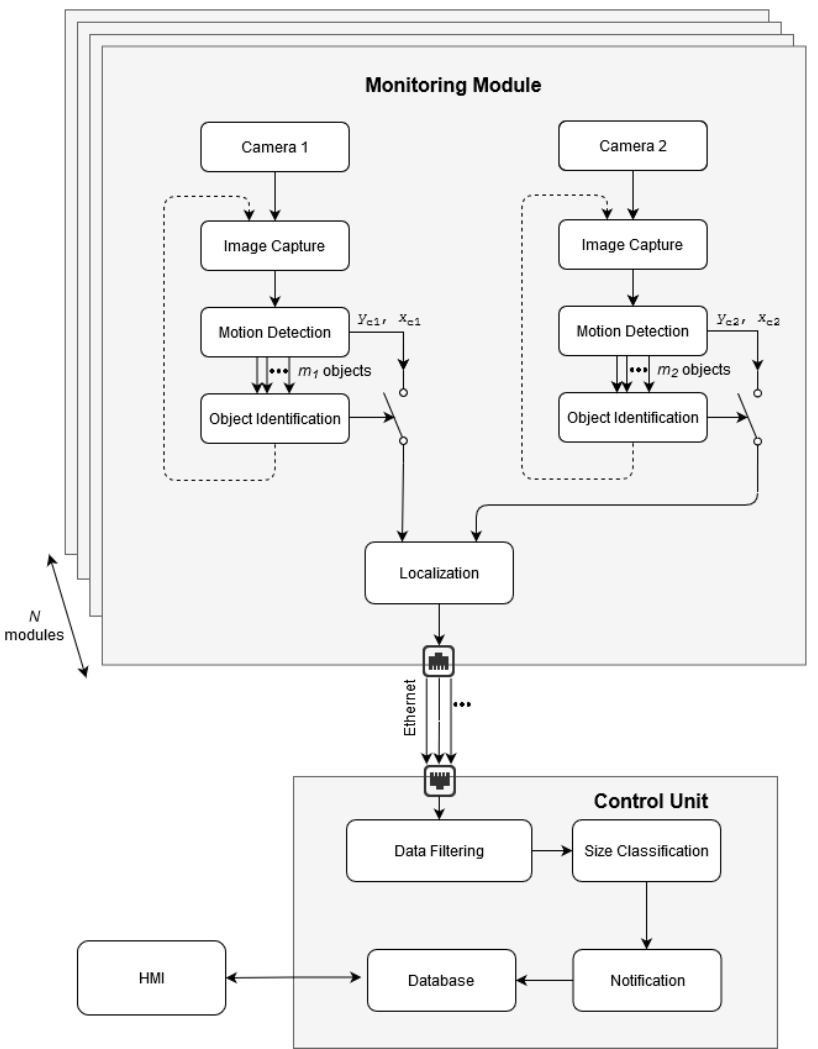
Figure 7. General system processing architecture consisting of N monitoring modules and the control